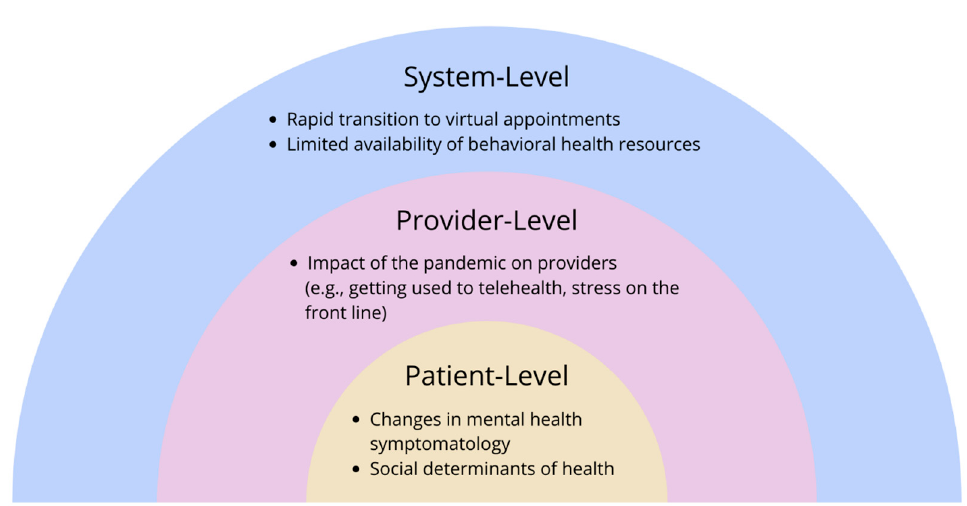
Figure 1. Factors influencing pediatric primary care providers’ ability to deliver mental health care during the COVID-19 pandemic as reported by participants, an adapted social-ecological framework.